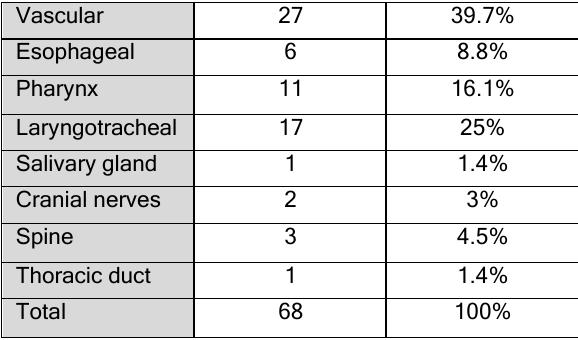
Table (7) Injured Neck structures